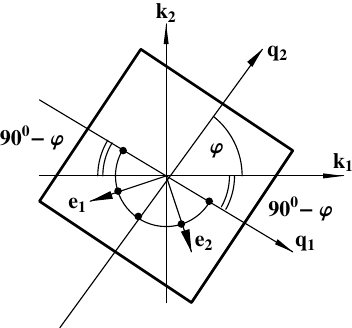
Figure 8. The position of a single crystal in a polycrystal; the orthonormal coordinate systems ( q are associated with single crystals, the general orthonormal coordinate system ( k 1 , k 2 ) are associated with the